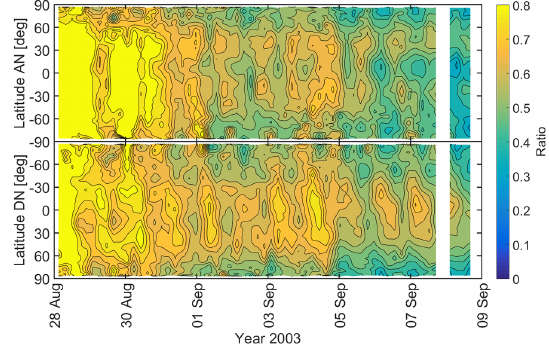
Figure 12. Density ratio (GITM / CHAMP) as a function of time and latitude for “case c” (LTAN = 06:44; LTDN = 18:44; h apogee = 423km; h perigee = 392km).